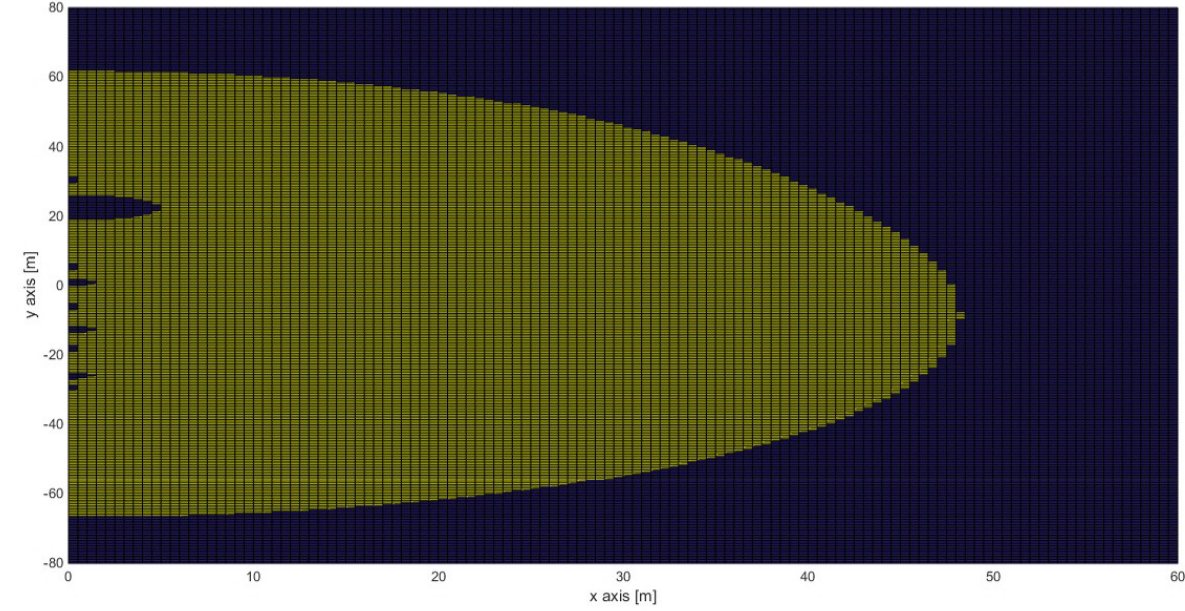
Figure 28. Area of electric field strength, with values higher (yellow) and lower (blue) than the limit of 1.25 V/m for method “C” of linear current source, for an electrode station of 6 linear frames in a row with d frames = 6.50 m; each frame consists of 13 electrodes of active length L = 2.13 m, D el = 0.50 m, ρ w = 0.25 Ω · m, θ = 248 ◦ (area of Korakia), J full_load_steady = 22 A/m 2 (steady state and operation of 5 frames, except no.